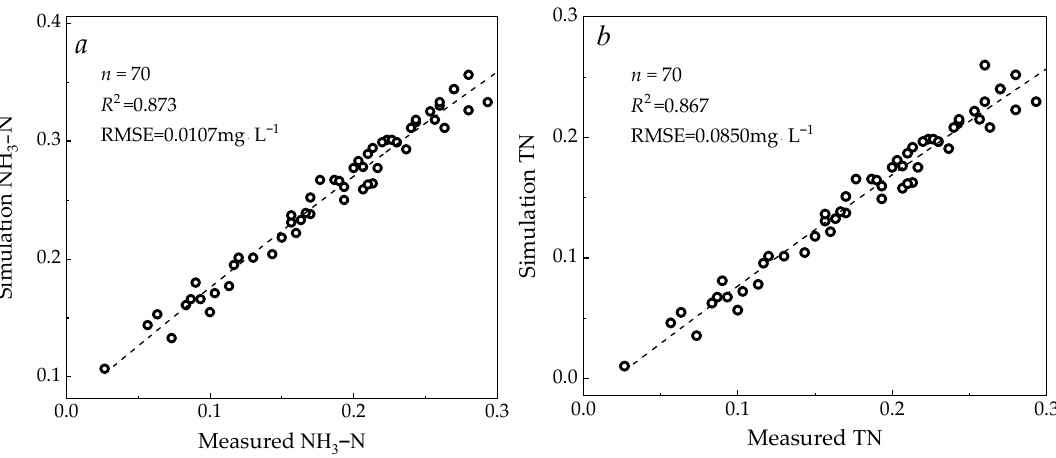
Figure 5. Accuracy of linear relationship between predicted and measured concentrations of NH 3 -N ( a ) and TN ( b ). RMSE , root mean square error.